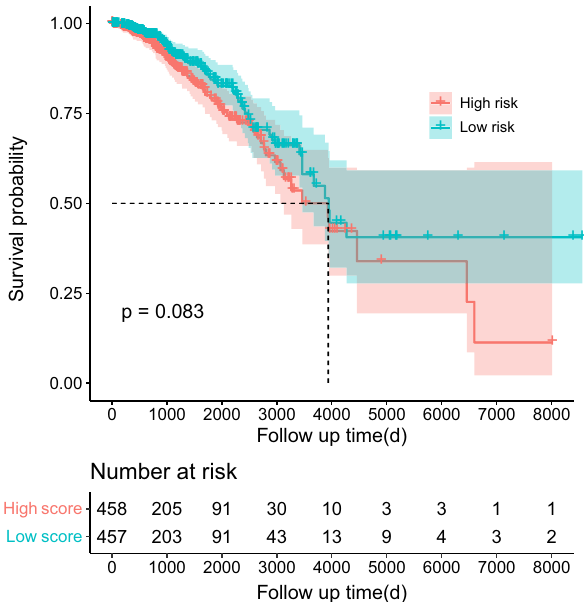
Figure A4: Prognosis analysis between high risk and low risk groups in the non - TNBC patients.